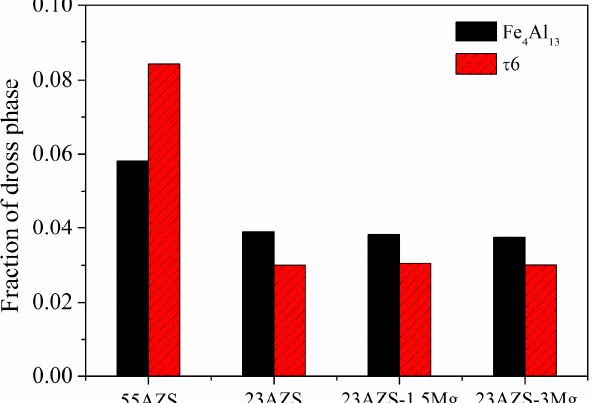
Figure 19. The solubility of Fe in bath with different Al content.